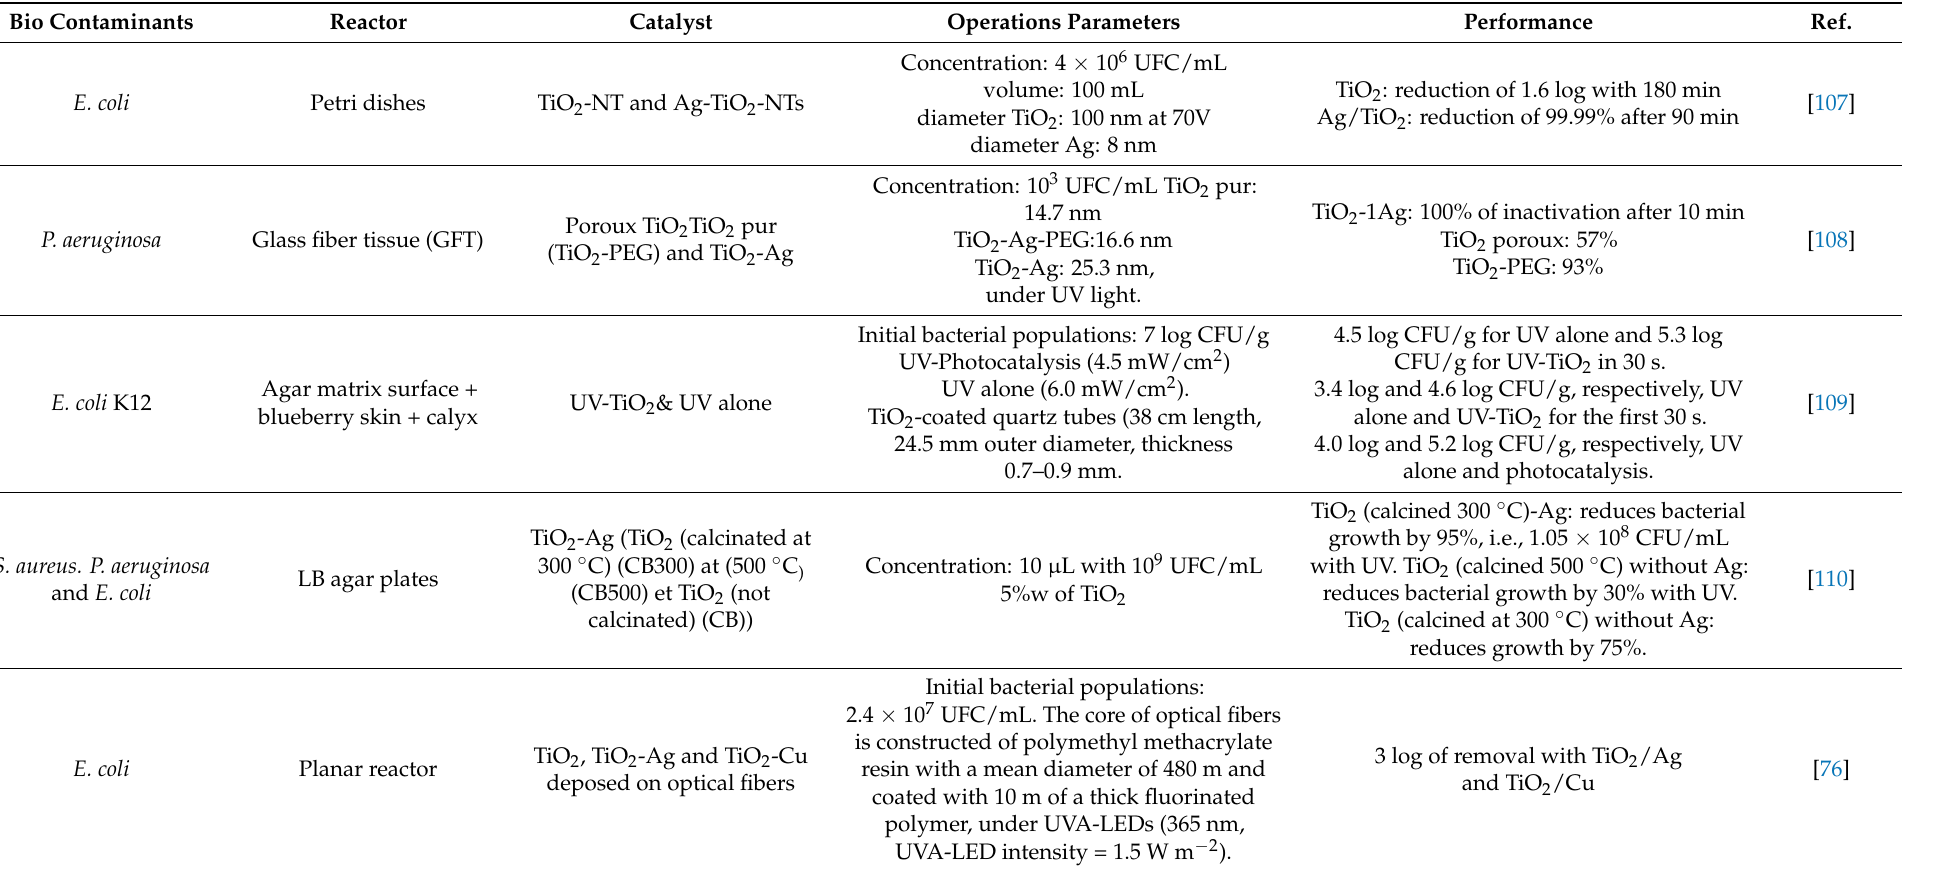
Table 2. List of some studies on using TiO 2 -metal for bacterial